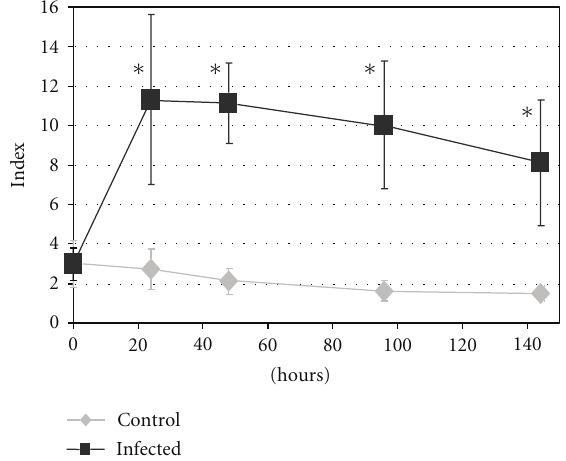
Figure 3: Mean concentration of seric galactomannan in control and experimentally infected turkeys. Index = optical density of the sample/mean optical density of two threshold samples (1ng/mL of galactomannan) provided in the Platelia kit. ∗ Significant di ff erence ( P < .